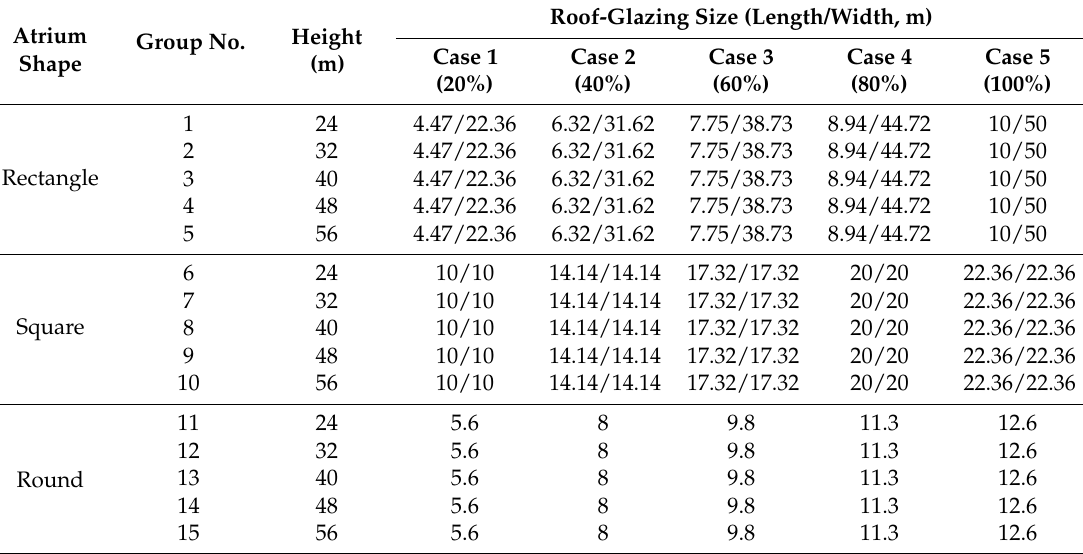
Table 1. Model information of Rectangle, Square, and Round atrium types.